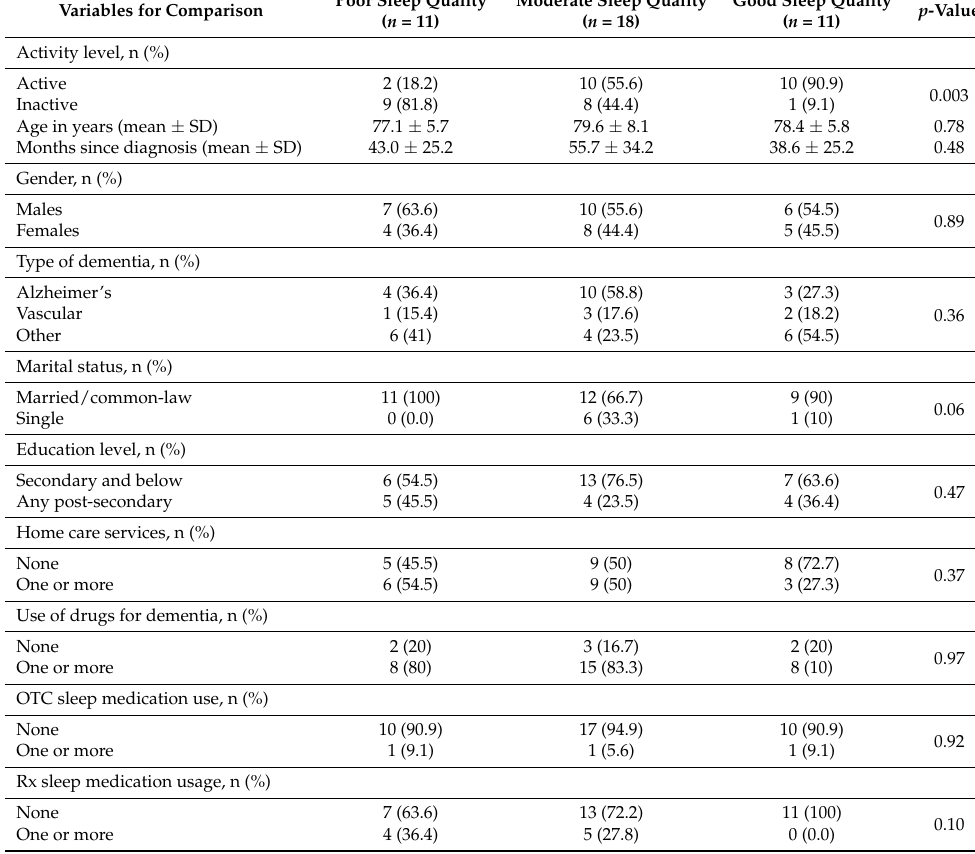
Table 4. Characteristics of PWD by sleep